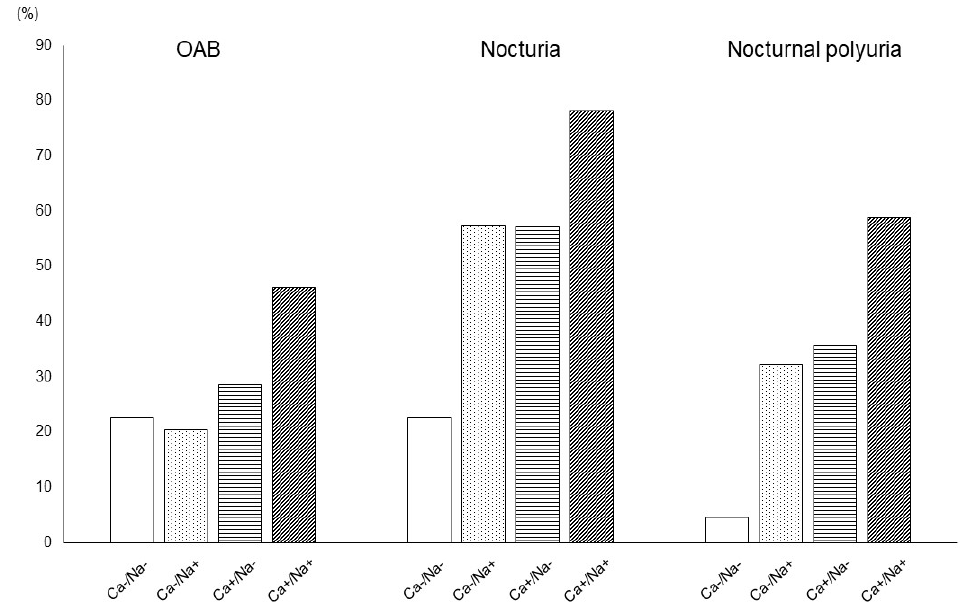
Figure 1. Relationship between the presence rate of various urinary parameters and salt intake and urinary calcium excretion.